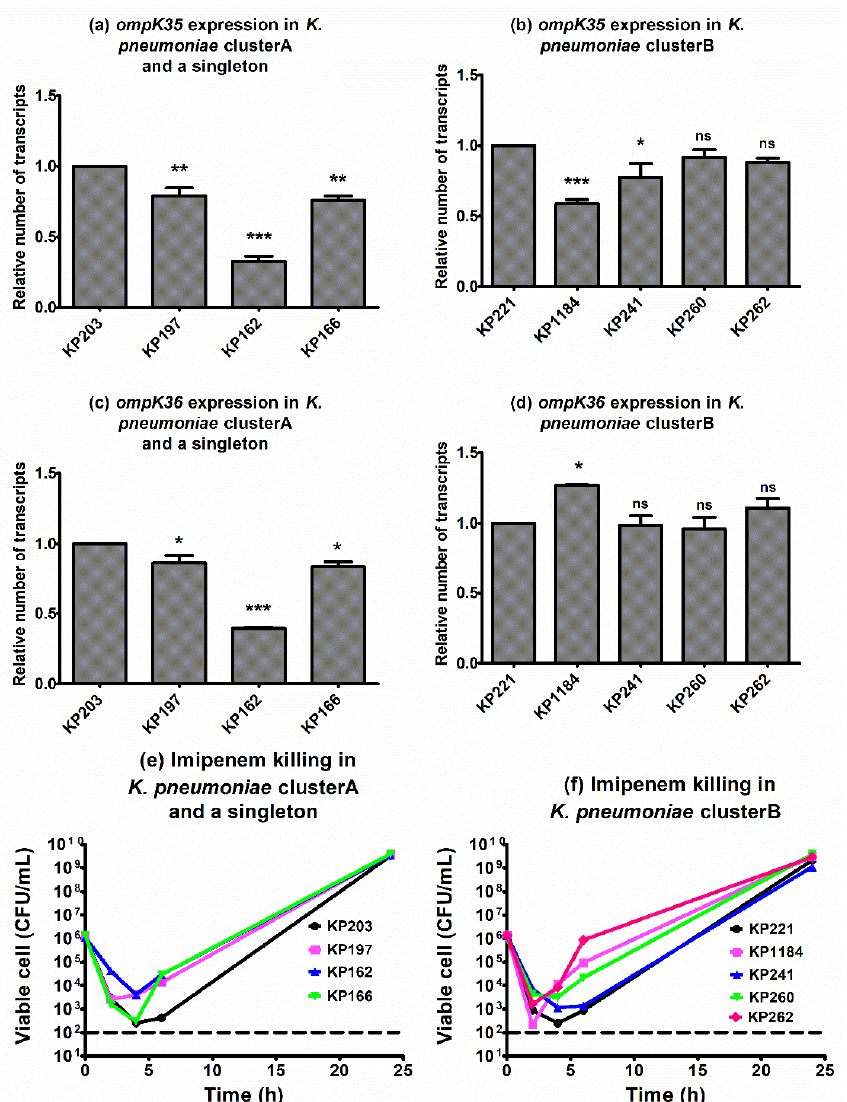
Figure 4. Relative ompK35 and ompK36 expression levels in K. pneumoniae . RT-qPCR assay of ompK35 and ompK36 expression was performed in K. pneumoniae cluster A ( a , c ), a singleton isolate KP162 ( a , c ), cluster B ( b , d ). The relative number of ompK35 and ompK36 transcripts of K. pneumoniae isolates was normalized to 16S rRNA expression and calculated using the 2 − ∆∆ ct method compared to the expression of imipenem-susceptible K. pneumoniae isolates KP203 and KP221. p -values were calculated using unpaired t -test (*, p -value < 0.05; **, p -value < 0.01; ***, p -value < 0.001 and ns, non-significant). Killing effect of imipenem against K. pneumoniae cluster A and a singleton ( e ), and cluster B ( f ). Mean of bacterial viable cells at the treatment with 1 × MIC of imipenem was plotted at 0, 2, 4, 6, and 24 h of incubation. All experiments were performed in triplicate and the detection limit of the viable cells was 10 2 CFU/mL (dashed lines).